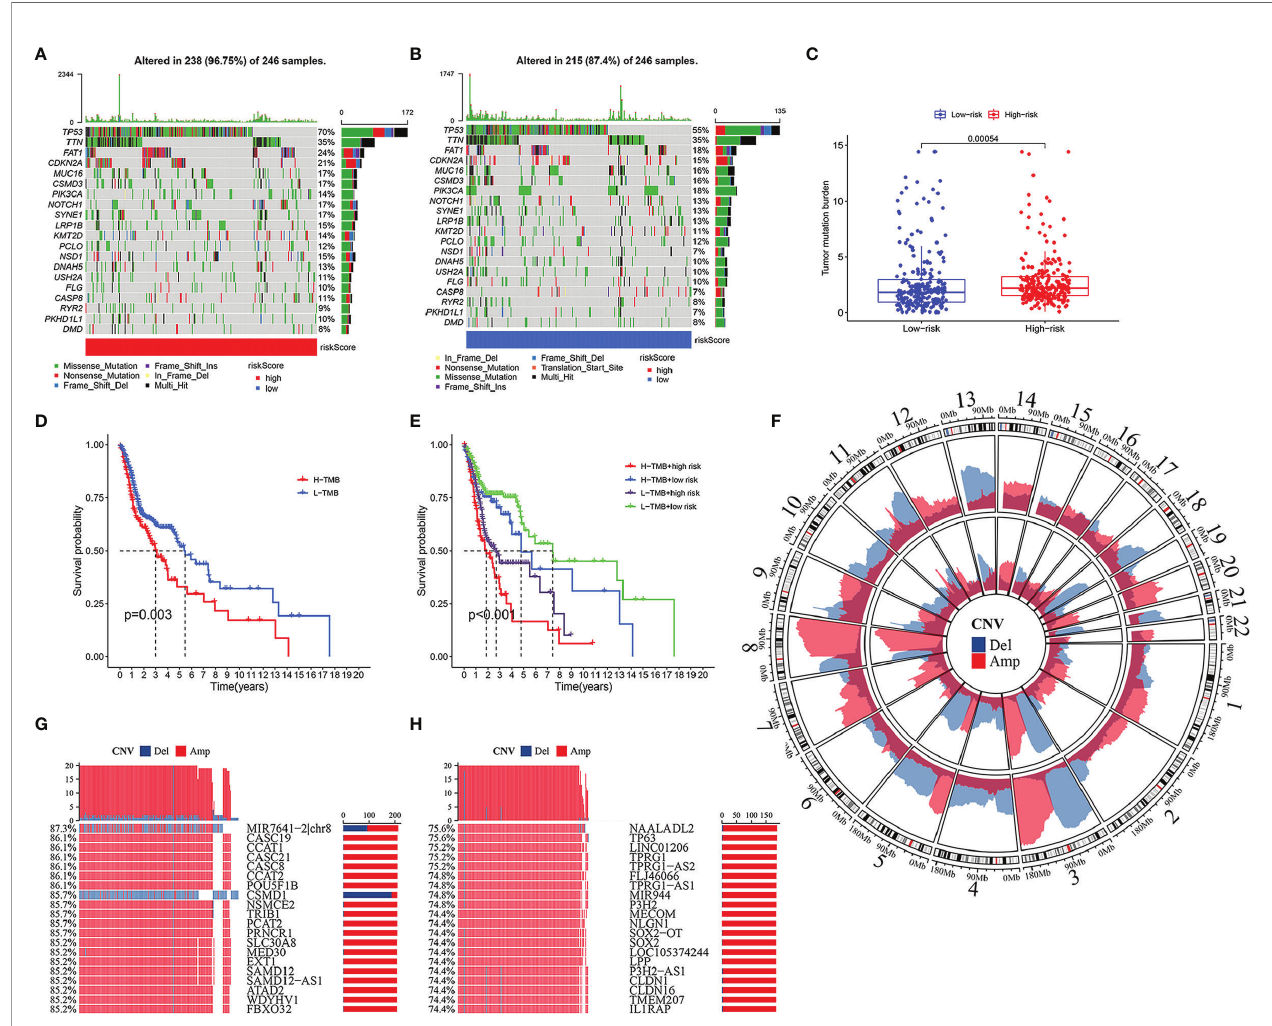
FIGURE 8 | Somatic mutation and copy number variations (CNVs) in high- and low-risk groups. Heatmap of somatic mutations in high-risk group (A) and low-risk group (B) . The difference of tumor mutation burden between high- and low-risk groups (C) . Kaplan – Meier curves showing the differences in high- and low-tumor mutation burden (TMB) groups (D) . Kaplan – Meier curves revealing the differences in high-TMB and high-risk group, high-TMB and low-risk group, low-TMB and high-risk group, and low-TMB and low-risk group (E) . Ampli fi cation and deletion of copy number in the high-risk group (inner) and low-risk group (outer) (F) . The 20 genes with maximum CNVs in high-risk group, and the percentage meaning the proportion of patients with head and neck squamous cell carcinoma (HNSCC) who suffered gene deletion (blue) or ampli fi cation (red) in high-risk group (G) . Top 20 genes with maximum CNVs in low-risk group, and the percentage representing the ratio of patients with HNSCC who suffered gene deletion (blue) or ampli fi cation (red) in low-risk group (H)